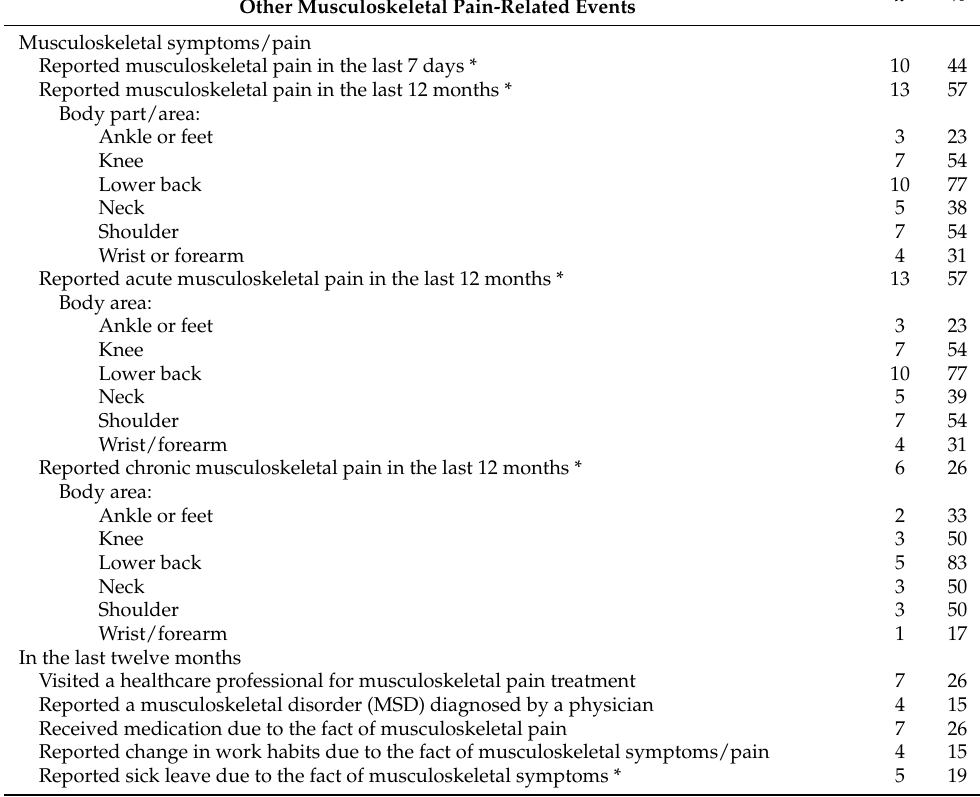
Table 2. Musculoskeletal pain and other musculoskeletal pain-related events among participants ( n = 27).